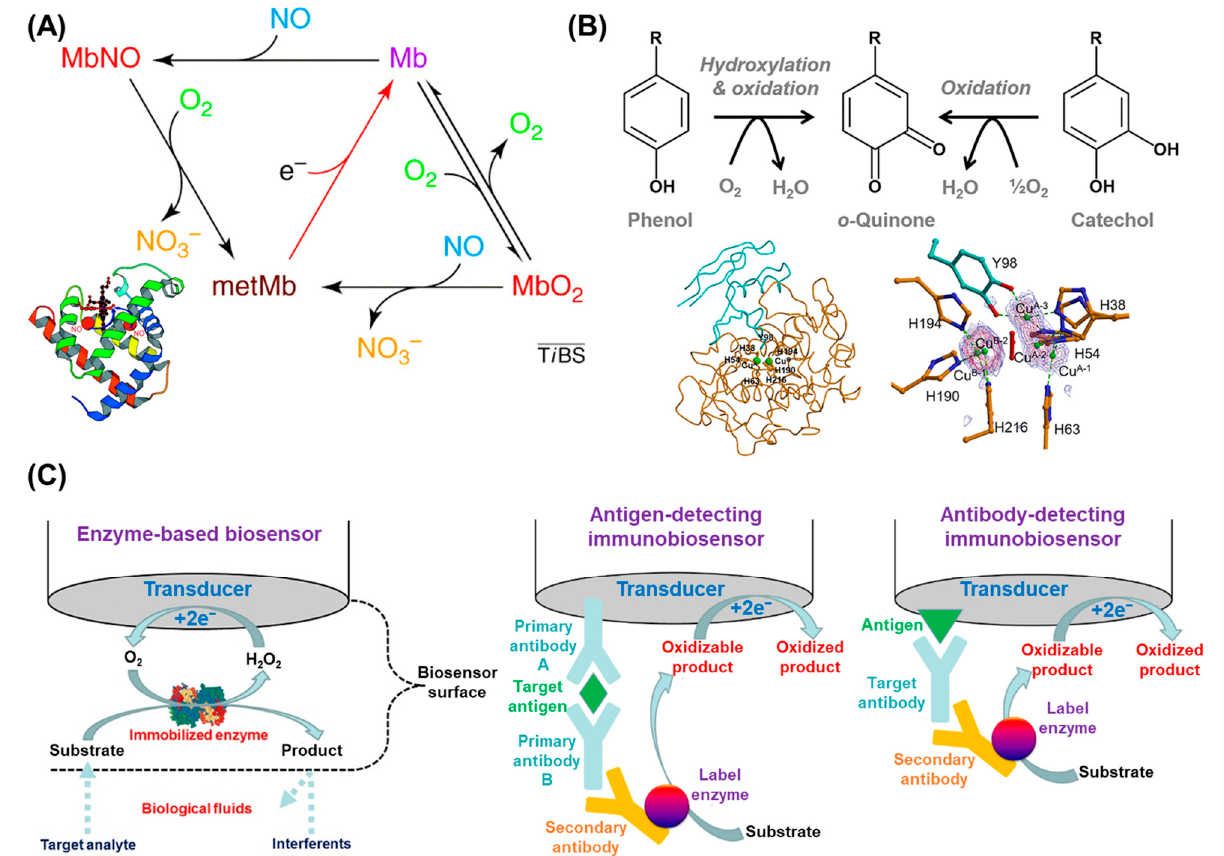
Figure 2. ( A ) Structure of Mb for reaction with NO, and its enzymatic reaction process for detection of NO by regulation of its states, Reprinted with permission from ref. [33]. Copyright © 2001, Elsevier Science Ltd., ( B ) Schematic diagram of enzymatic reactions of the Tyr using its copper ions for conversion of catechol and phenol to o -quinone, and its structure containing copper ions, Reprinted with permission from ref. [39]. Copyright © 2018 by the authors, ( C ) Schematic representation of enzyme-based biosensors. Examples of conventional enzymatic biosensors (left) and immune biosensors that employ an enzyme as a labeling component for the indirect detection of a target antigen (middle) or a target antibody (right), Reprinted with permission from ref. [48]. Copyright © 2016 by the authors, Licensee MDPI.